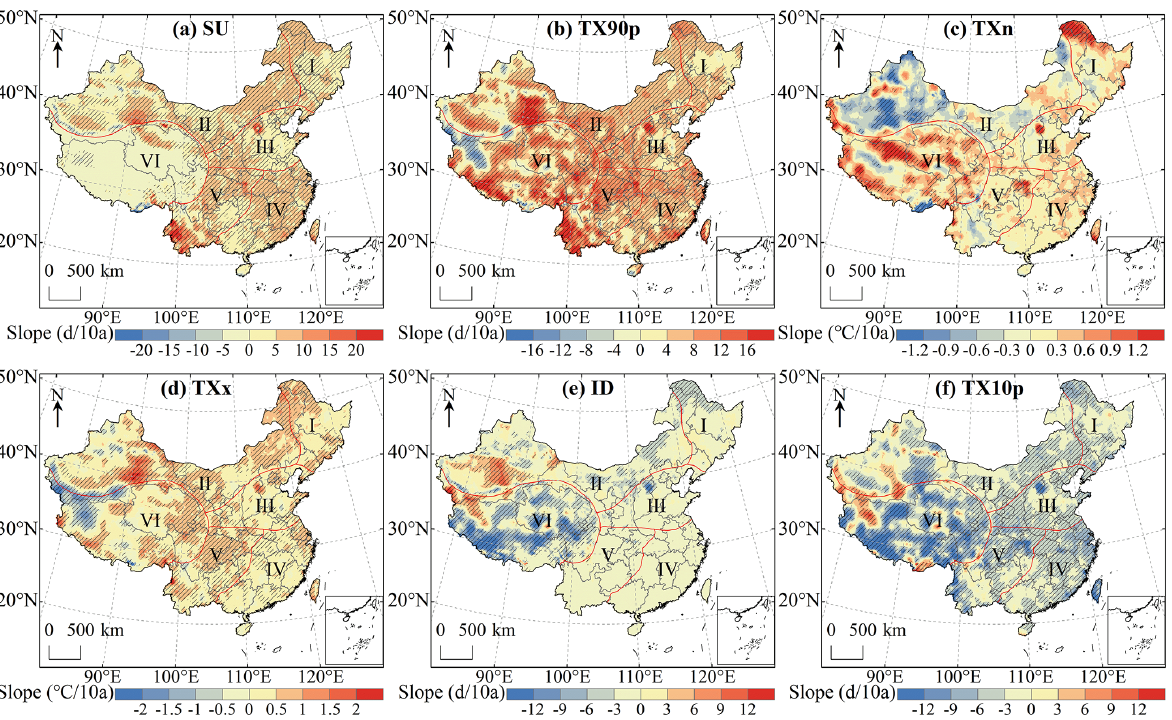
Figure 16. Spatial distribution of trends in extreme temperature indices over China during 1979–2018. The shaded areas indicate trends that are significant at the 0.05 level.